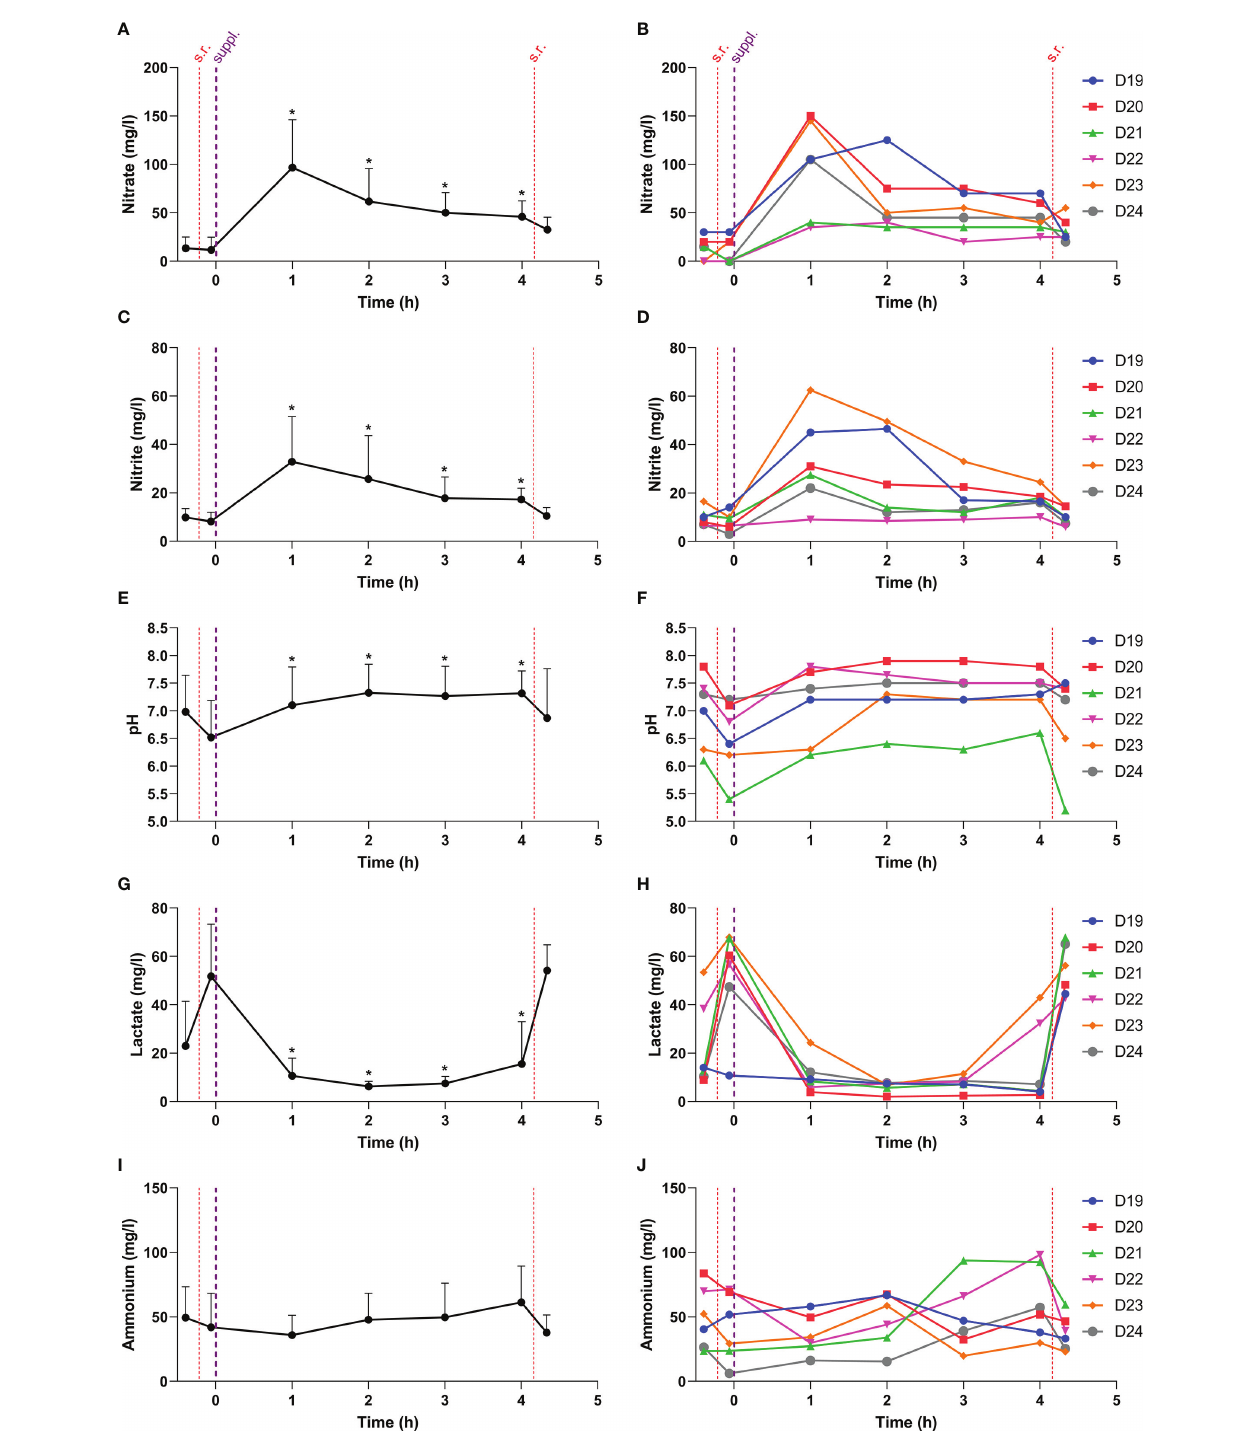
FIGURE 5 | Changes in physiological parameters during the 4 h after taking a nitrate-rich supplement. In this fi gure, the salivary nitrate (A, B) , nitrite (C, D) , pH (E, F) , lactate (G, H) and ammonium (I, J) are shown over time. The red lines are sugar rinses dividing pre- and post-sucrose measurements at baseline (0 h) and after 4 h of supplement intake. The thicker purple line represents when the nitrate-rich supplement was consumed. On the left side, the averages are shown with standard deviations. The time points 1 h, 2 h, 3 h and 4 h (pre-sucrose) were compared to 0 h (pre-sucrose). * = compared to 0 h (pre-sucrose), the p-value was < 0.05. On the right side, the individual donors are shown. S.r., sugar rinse; Suppl., supplement intake. In Figure 6, the pre- and post-sucrose measurements are